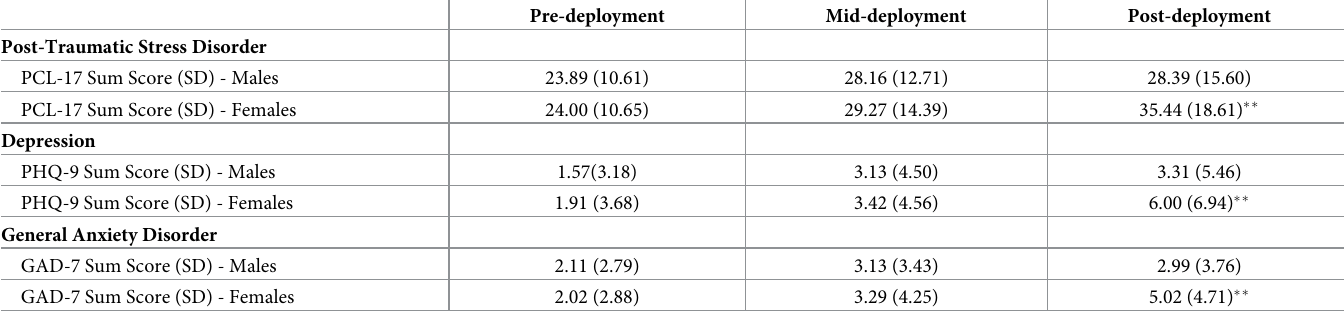
Table 4. Gender differences in mental health outcomes at each time points.